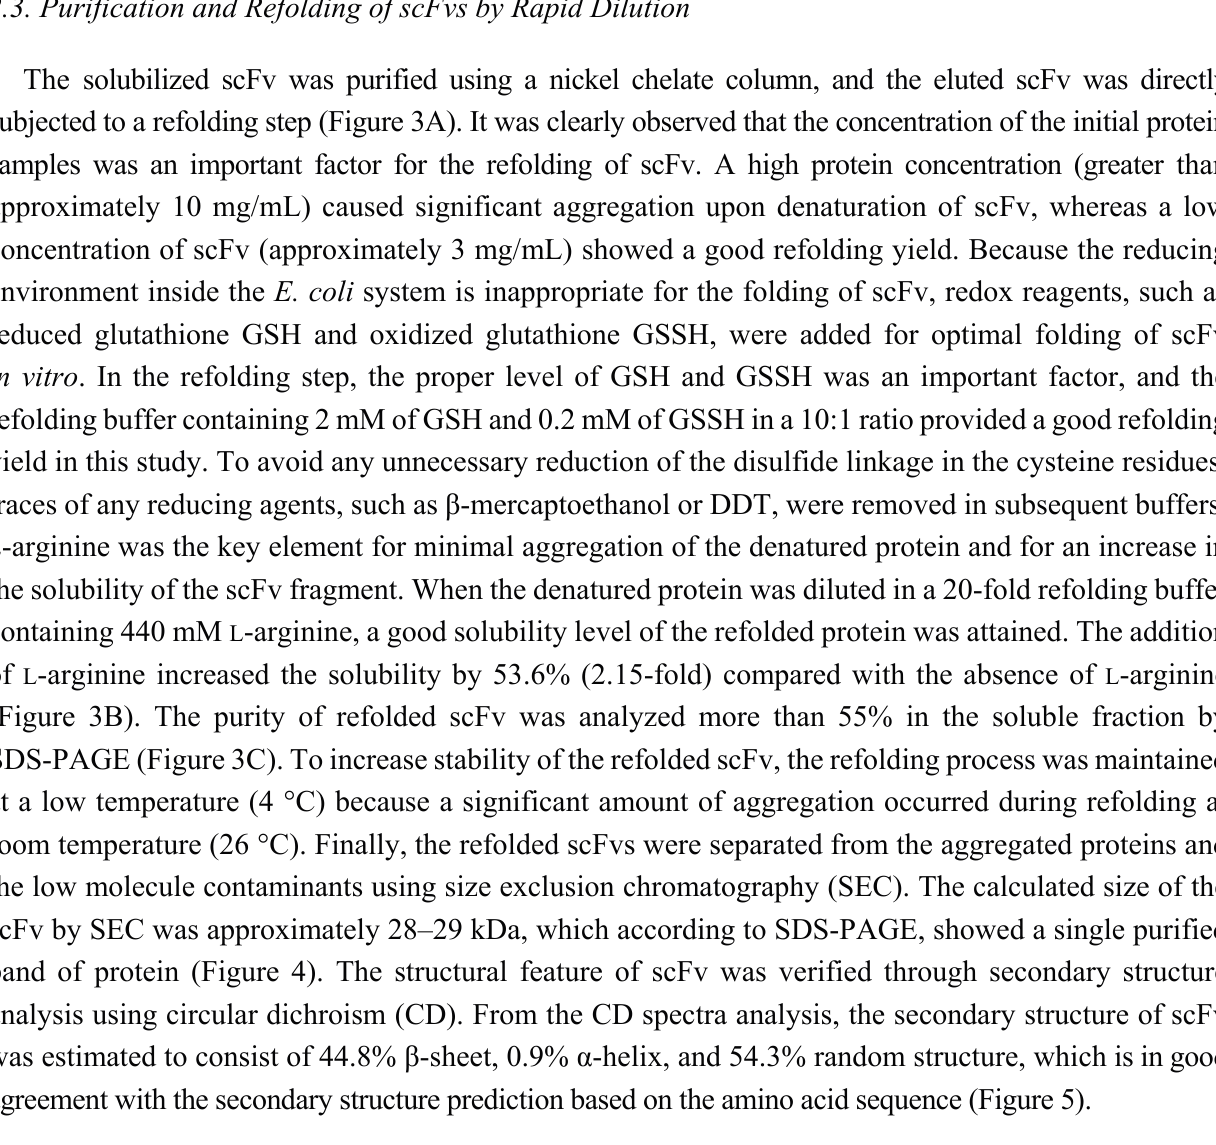
Figure 3. Purification and refolding of the scFv antibody fragment. ( A ) Solubilized scFv was applied to a Ni-column and eluted by a gradient of 250 mM imidazole (lane 1, before column; lane 2, unbound; lane 3, wash); ( B ) The scFv fragment was refolded in the presence of 440 mM L -arginine and the redox reagents, 2 mM GSH and 0.2 mM GSSH (lanes 1 and 4, before refolding sample; lanes 2 and 5, the supernatant after refolding; lanes 3 and 6, the pellet after refolding); and ( C ) The final refolded scFv antibody